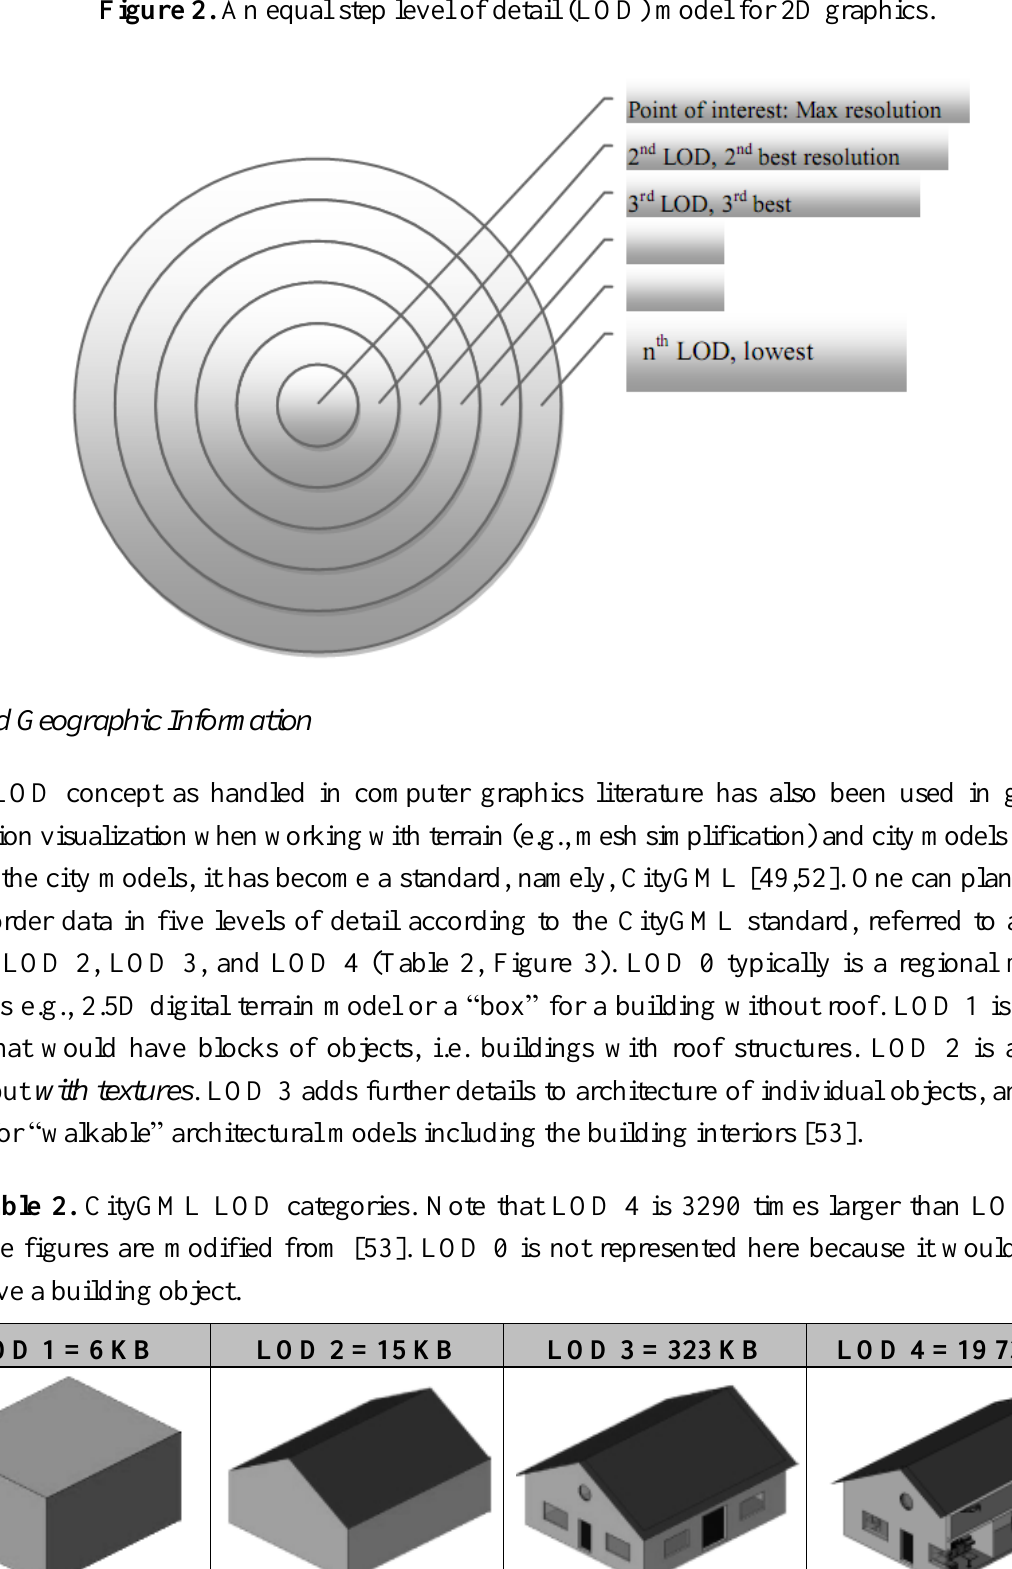
Figure 2. An equal step level of detail (LOD) model for 2D